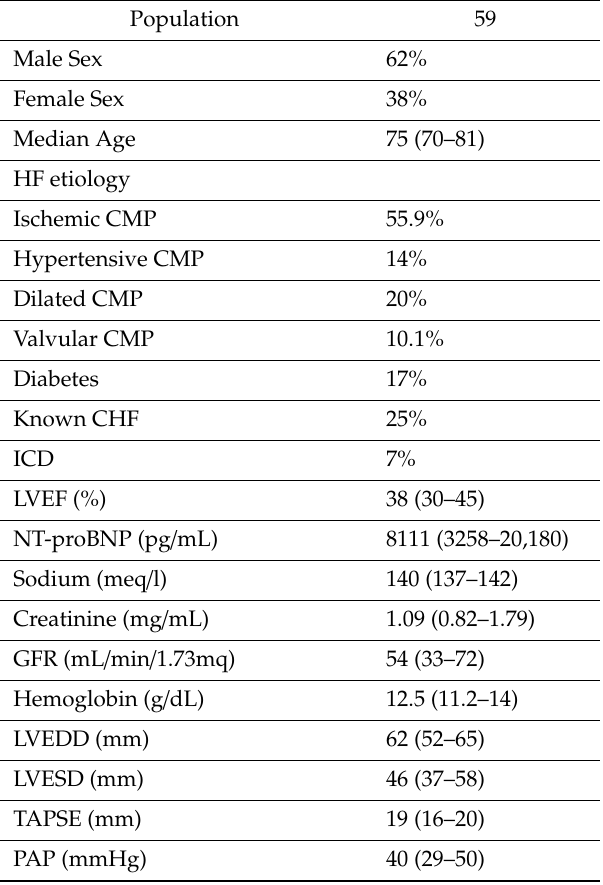
Table 1. General characteristics of the heart failure